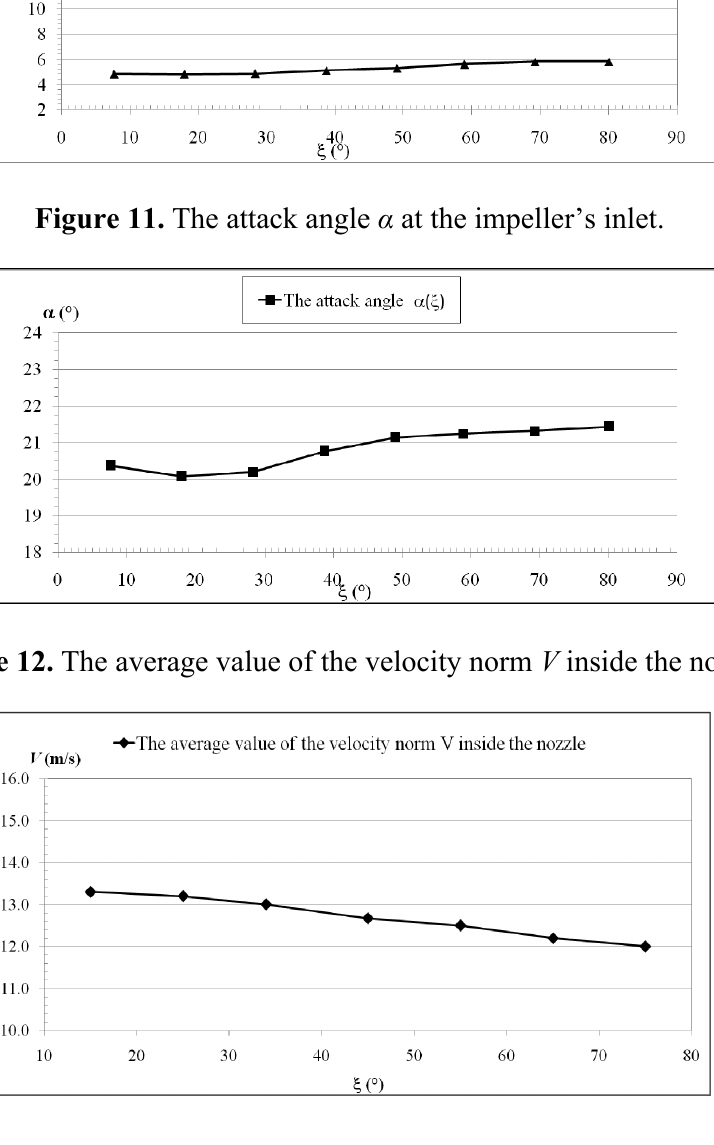
at the impeller’s inlet. r